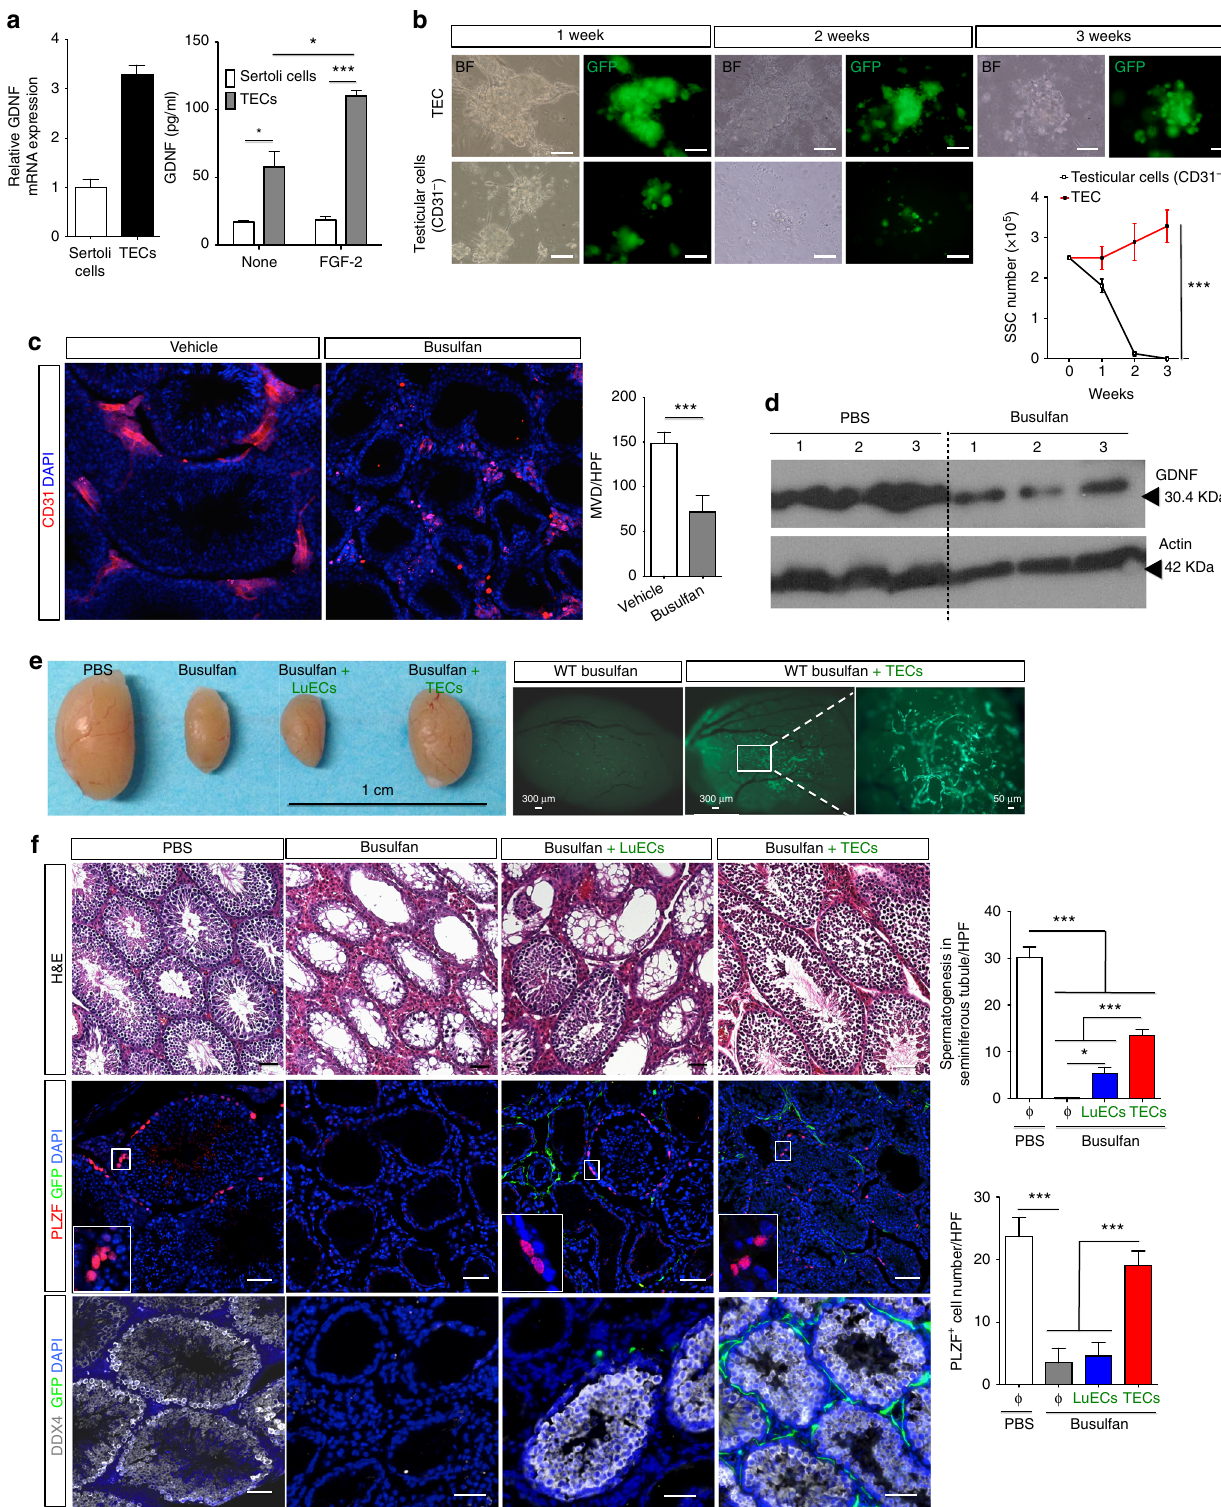
signi fi cant decrease in microvessel density (Fig. 1c). A